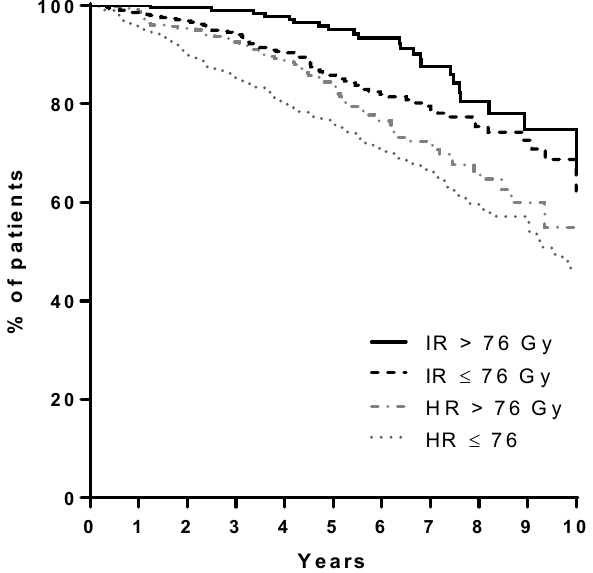
Figure 5. BRFS among intermediate risk patients (IR) and high risk patients (HR) treated with a total dose (E qD2) ≤ 76 Gy and > 76 Gy, log-rank p <